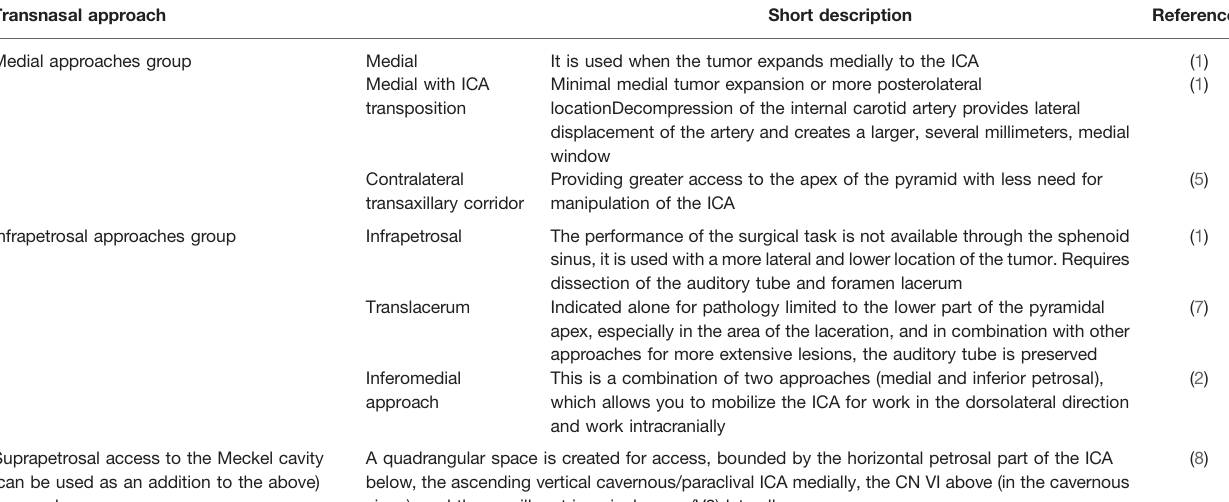
TABLE 1 | Endoscopic transnasal approaches to petrous